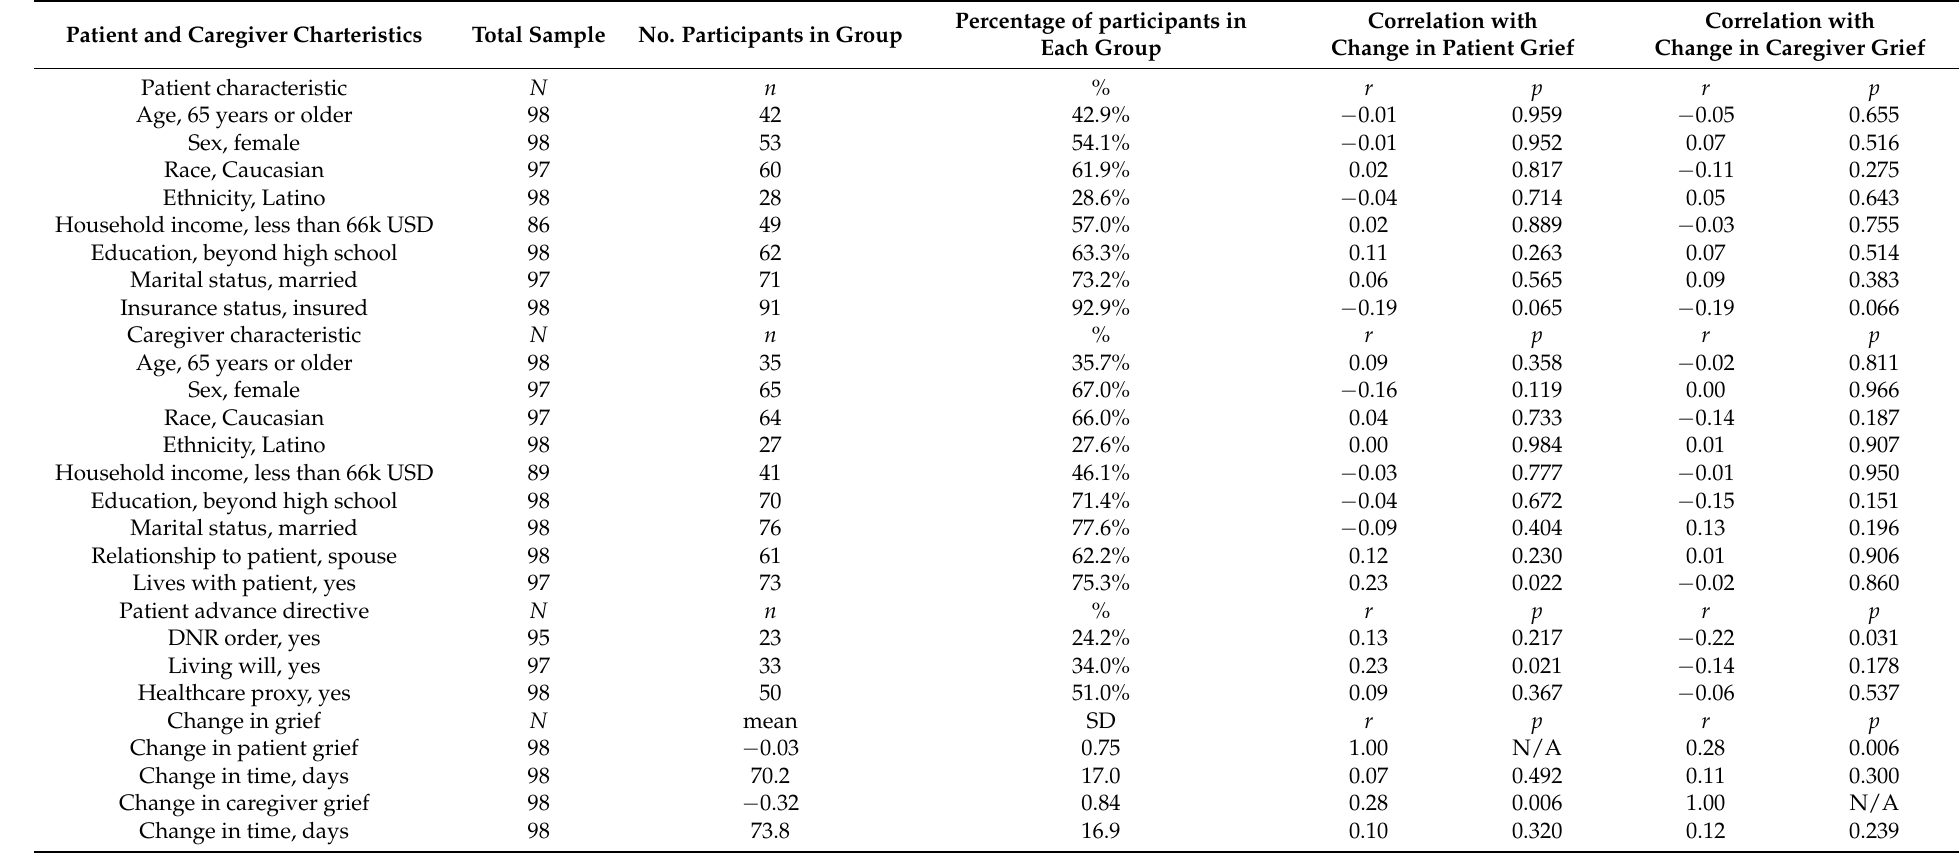
Table 1. Patient and caregiver characteristics, patient advance directives, and their associations with temporal changes in patient and caregiver grief ( n = 98). Patient and Caregiver Charteristics Total